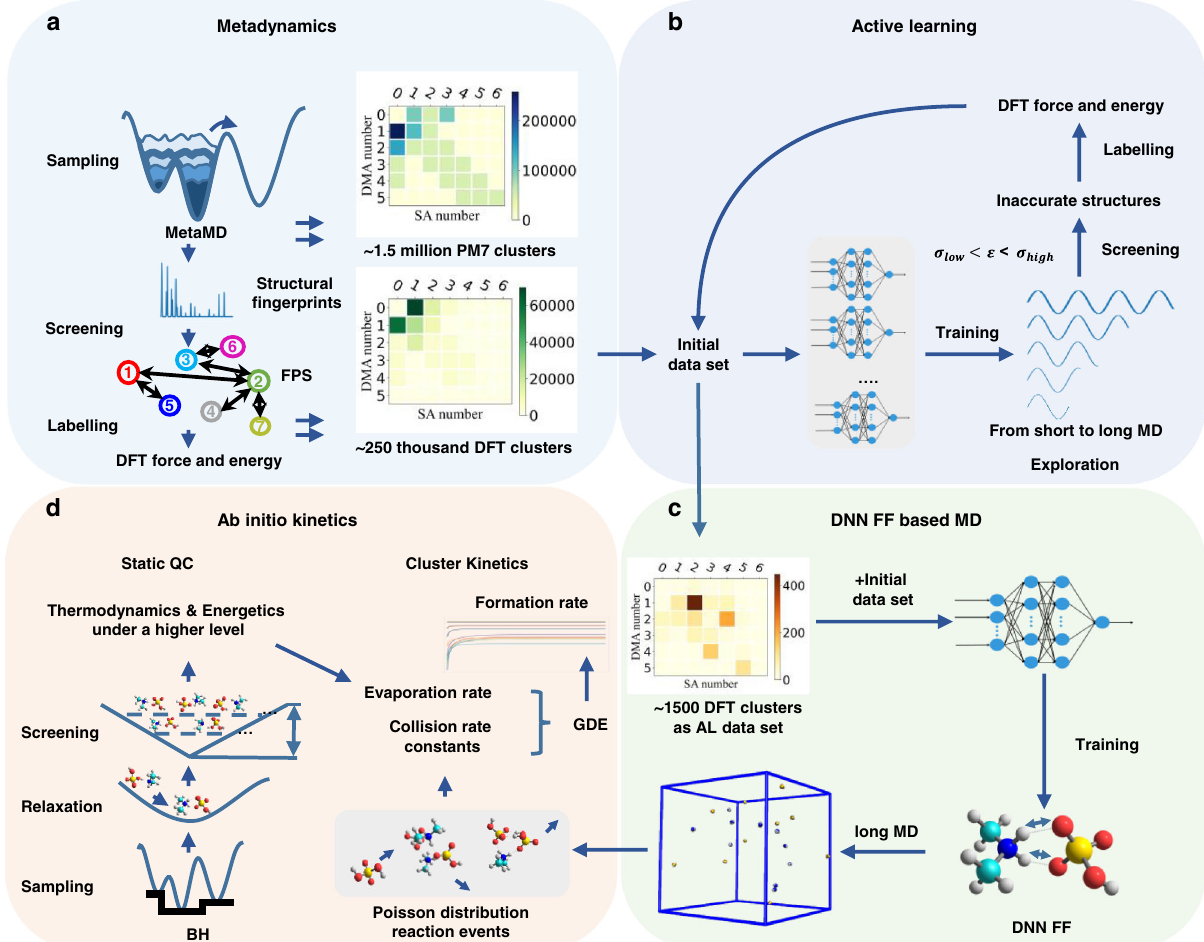
a , b show the metadynamicsand active learning techniques used to prepare a data set for the deep neural network, respectively. c DNN-FF-driven MD. d Cluster kinetics simulation based on MD-derived collision rate constants and static quan- tum chemistry (QC) calculation-derived evaporation